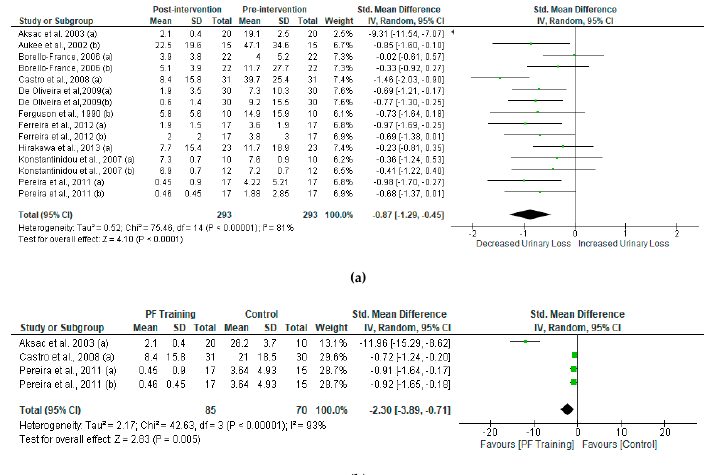
Figure 4. Standardized mean di ff erence (SMD) ( a ) between post- and pre-intervention urinary loss in women who received PFMT and ( b ) post-intervention intervention urinary loss in women who received PFMT. Squares represent the SMD for each trial. Diamonds represent the pooled SMD across trials. Sub-Group